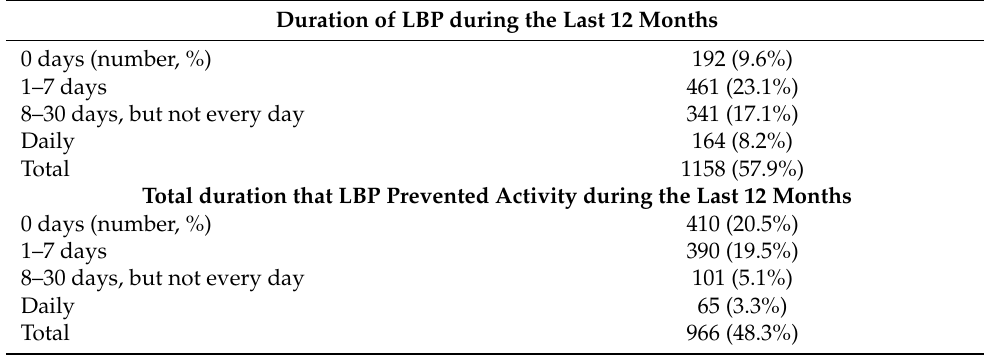
Table 1. Total duration of LBP and activity limitation during the last 12 months.